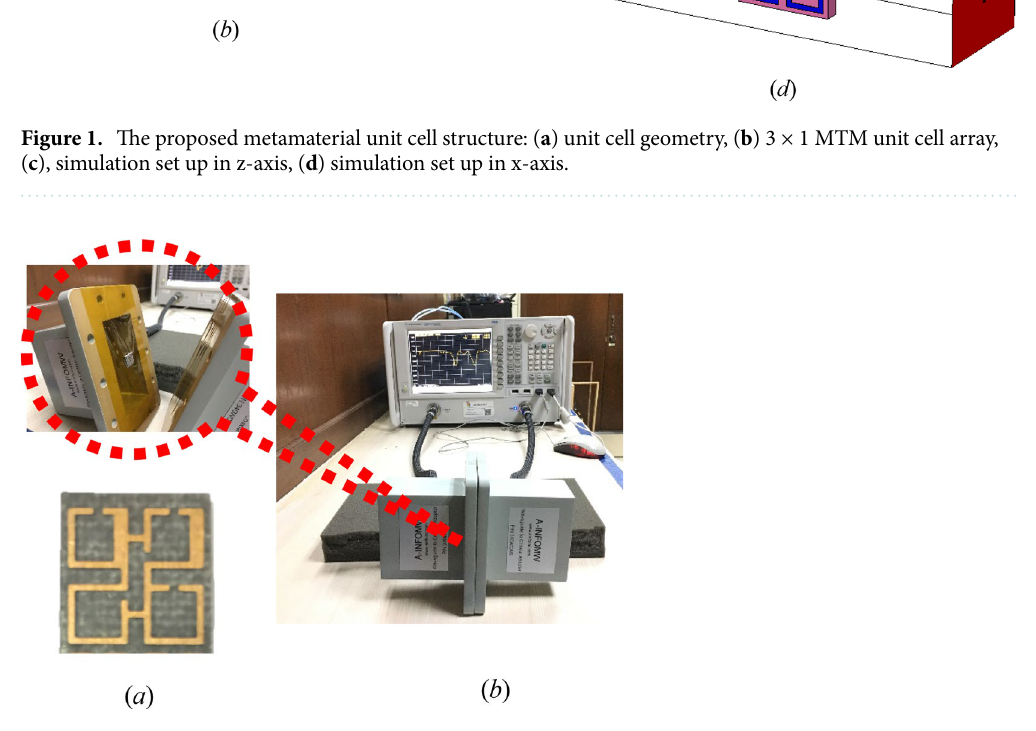
Figure 2. Metamaterial experimental setup: ( a ) measurement of MTM S-parameters, ( b ) unit cell with Horn